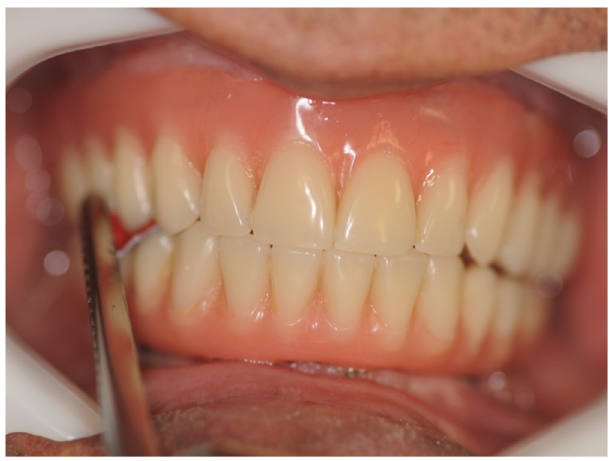
Figure 3. Evaluation of active tactile sensibility with carbon sheets in the premolar area of a participant with Branemark protocol prostheses (experimental group). The lip retractor facilitated access.